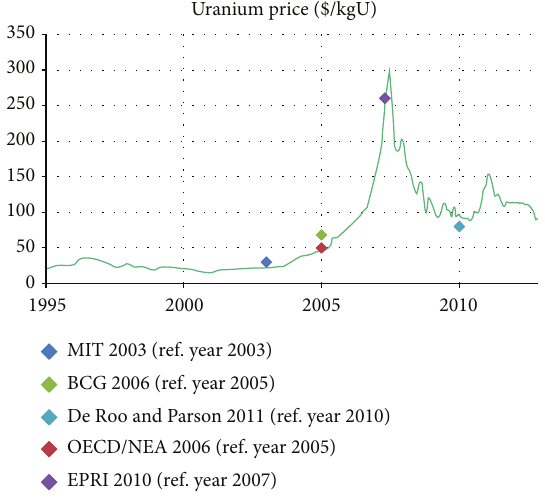
Figure 1: Uranium price.